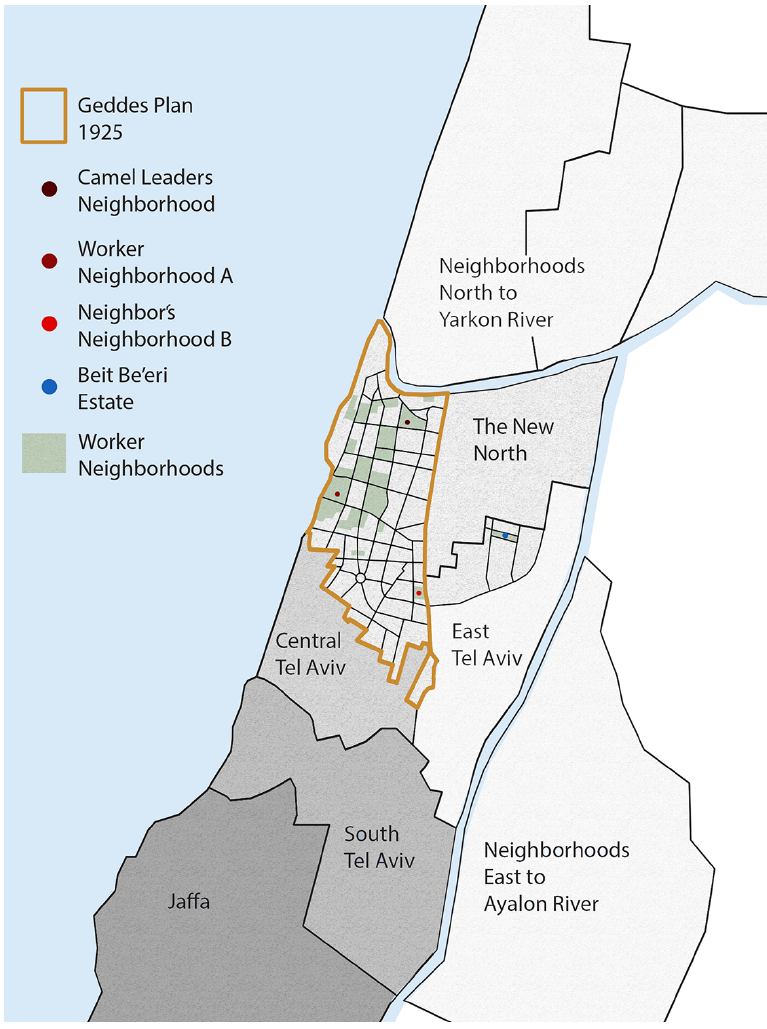
Figure 8. Scheme after Geddes’ plan area within contemporary Tel Aviv-Jaffa area, with the location of Worker Neighborhood A, Neighbors’ Neighborhood B, Camel Leaders Neighborhood and Be’eri Estate. Source: